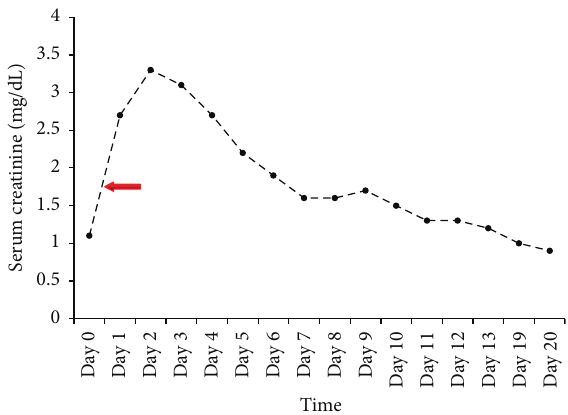
Figure 3: Time course of the serum creatinine in relation to the pelvic surgery (day 0) and the endovascular intervention (red arrow: time of